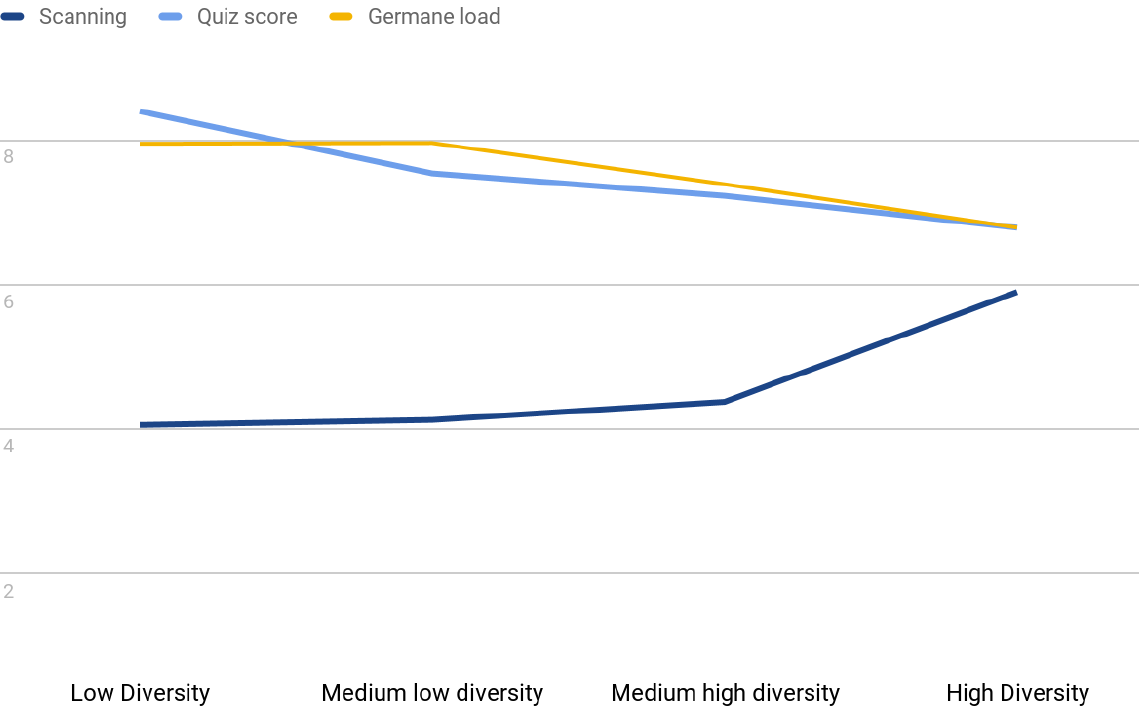
Figure 5. Main variable means by experiment